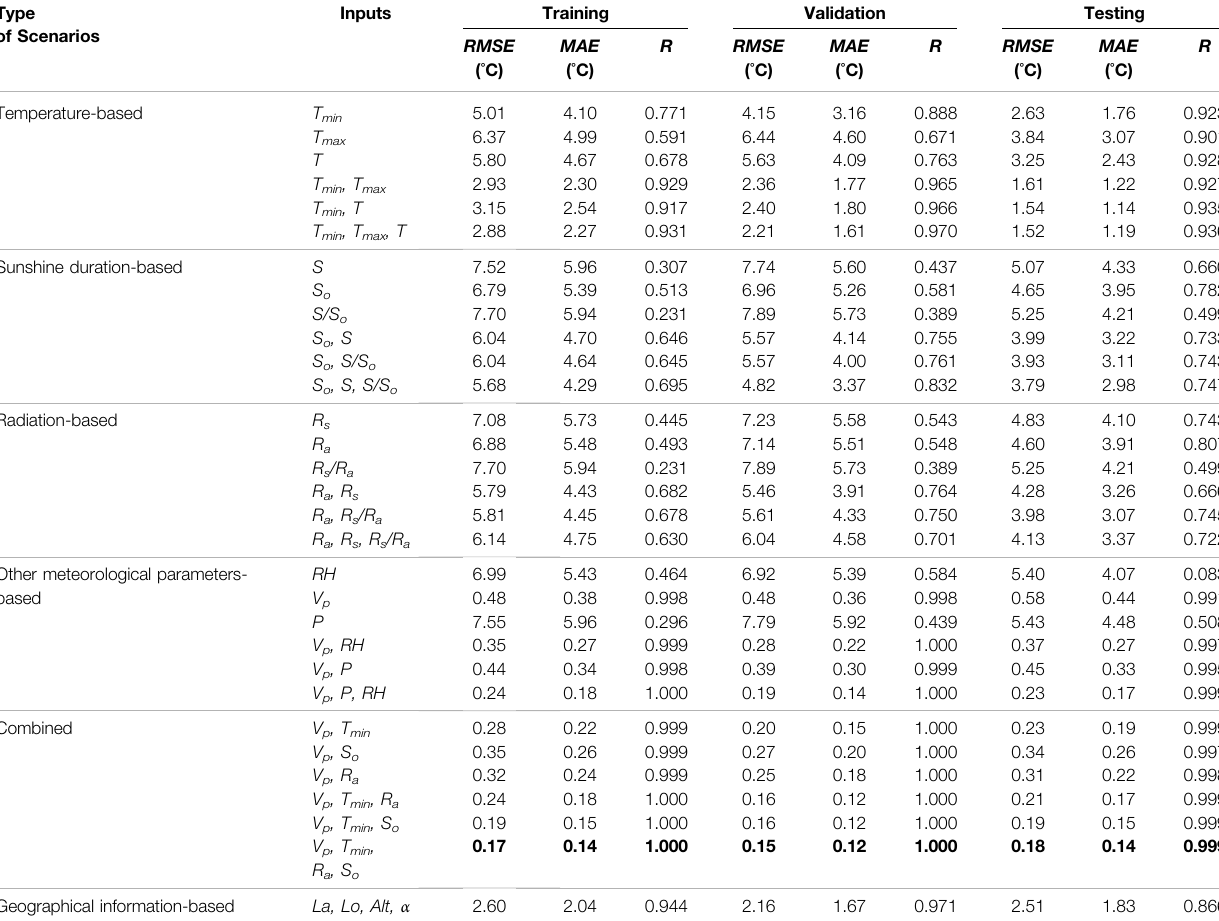
TABLE 4 | Statistical indices of T dew estimates from the MARS model for training, validation, and testing phases. Type of